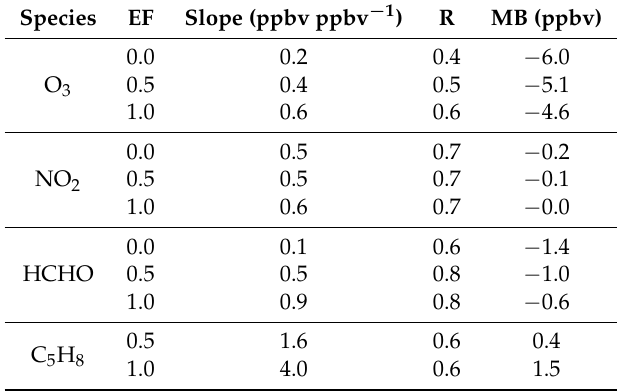
Figure 19. Comparison of measured and simulated ozone, isoprene, formaldehyde and nitrogen dioxide at the MUMBA site in Greater Sydney. Table 6. Table showing statistics for runs in which the biogenic emissions were scaled by various emission factors